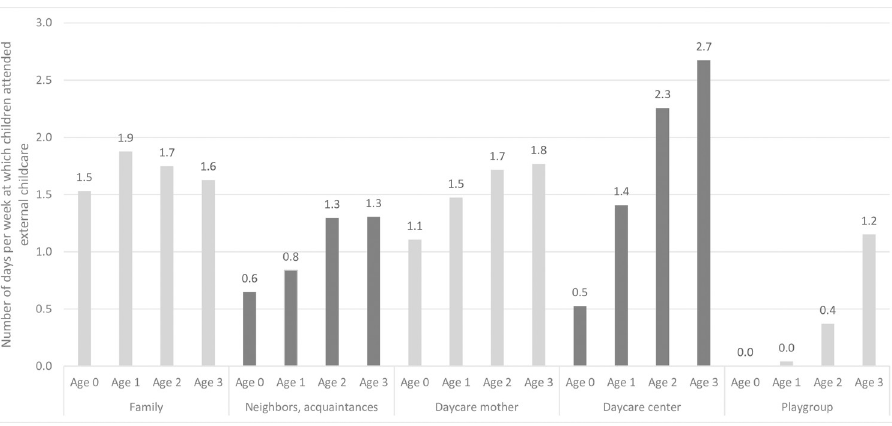
Fig 1. Number of days per week at which children attended external childcare by